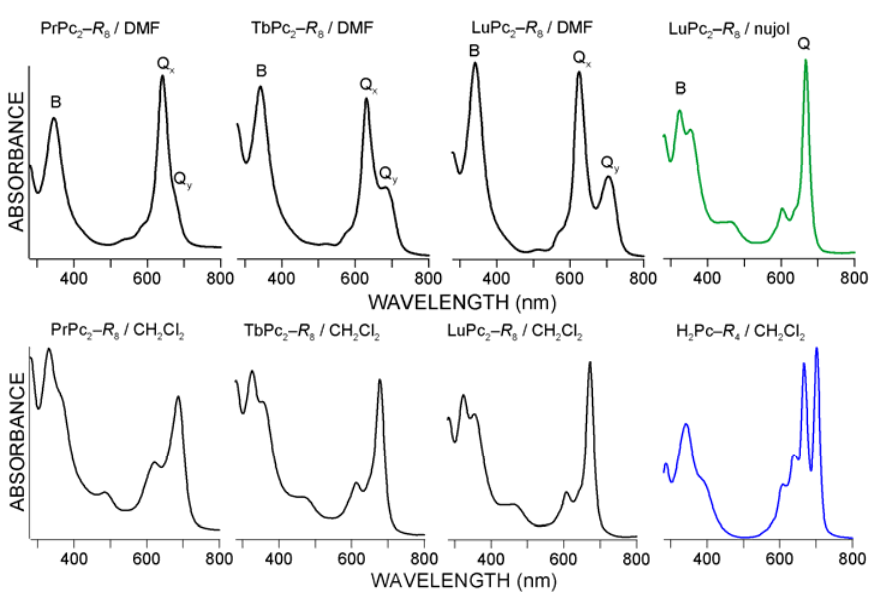
Figure 6. UV-Vis electronic absorption spectra-types registered for LnPc nujol (up) and in dichloromethane (down) including H